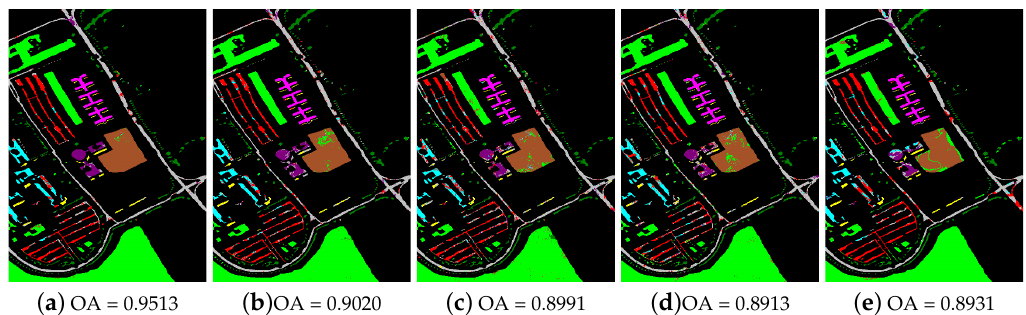
Figure 12. NN classification results on noisy Pavia University scene (noise variance σ = 500) obtained